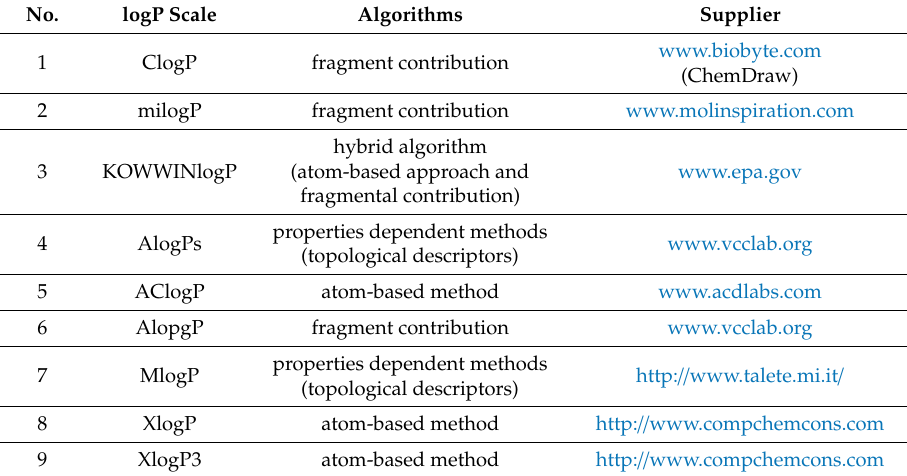
Table 2. Information about algorithms and suppliers of investigated